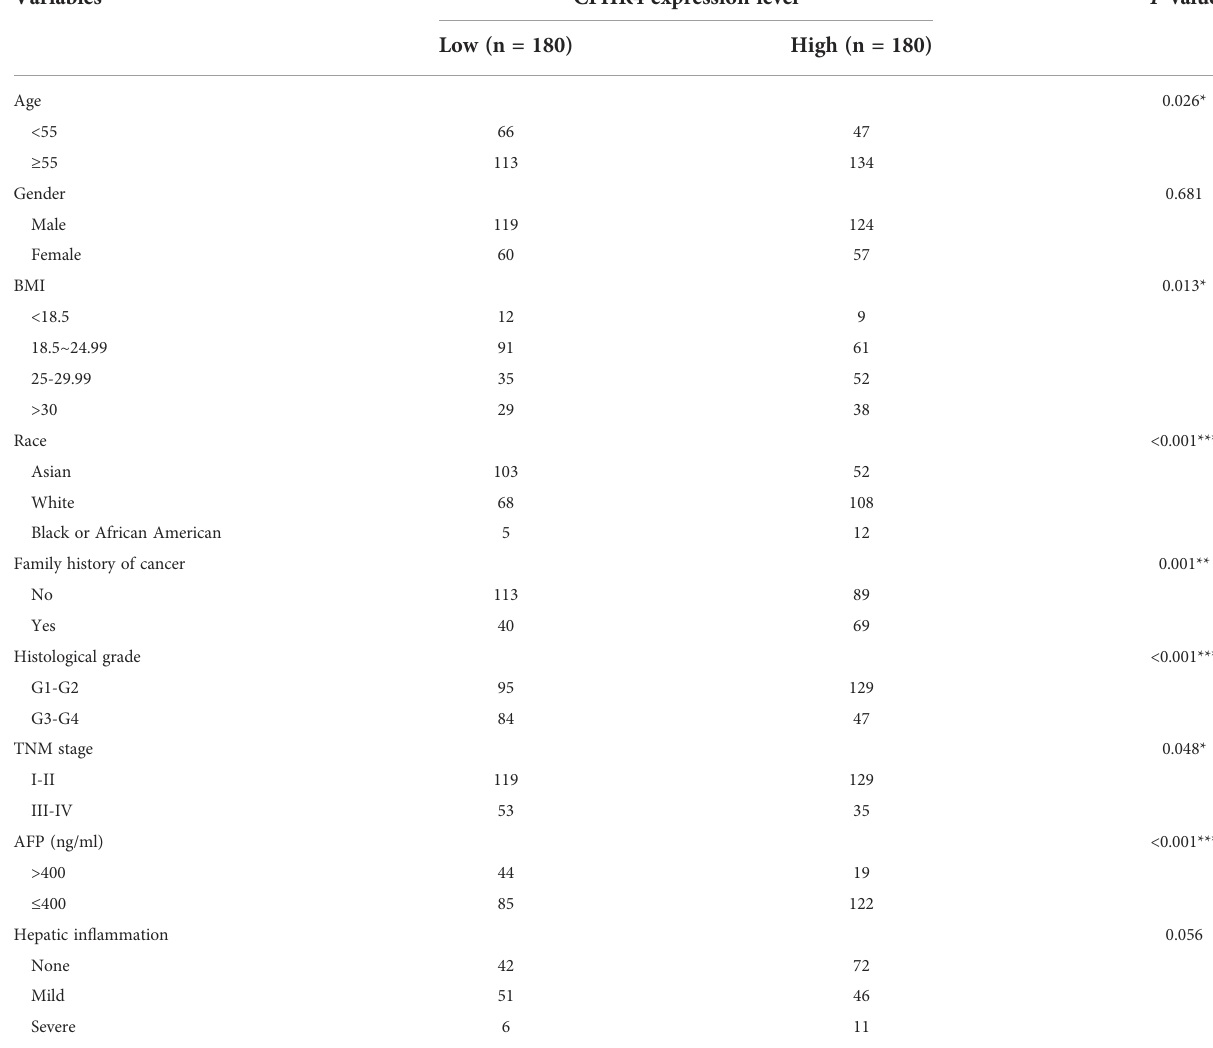
TABLE 4 The characteristics of HCC patients between CFHR4 high and low